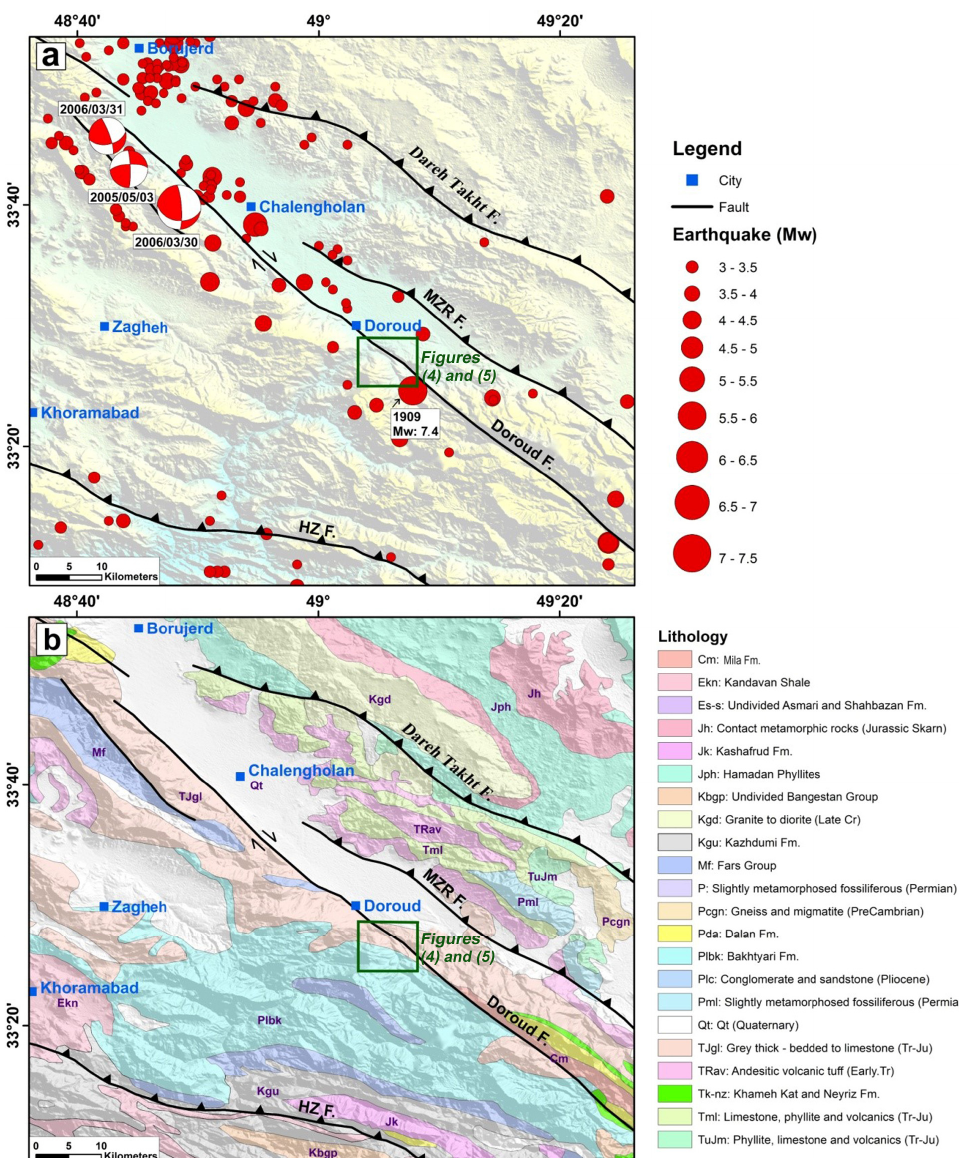
Figure 2. The sources of earthquakes catalogue and geological map: ( a ) seismotectonic map of northeastern Lorestan; ( b ) northeastern Lorestan geology map overlaid on a shaded relief map of the 10 m digital elevation model with active fault traces resulting from the Landsat images and field